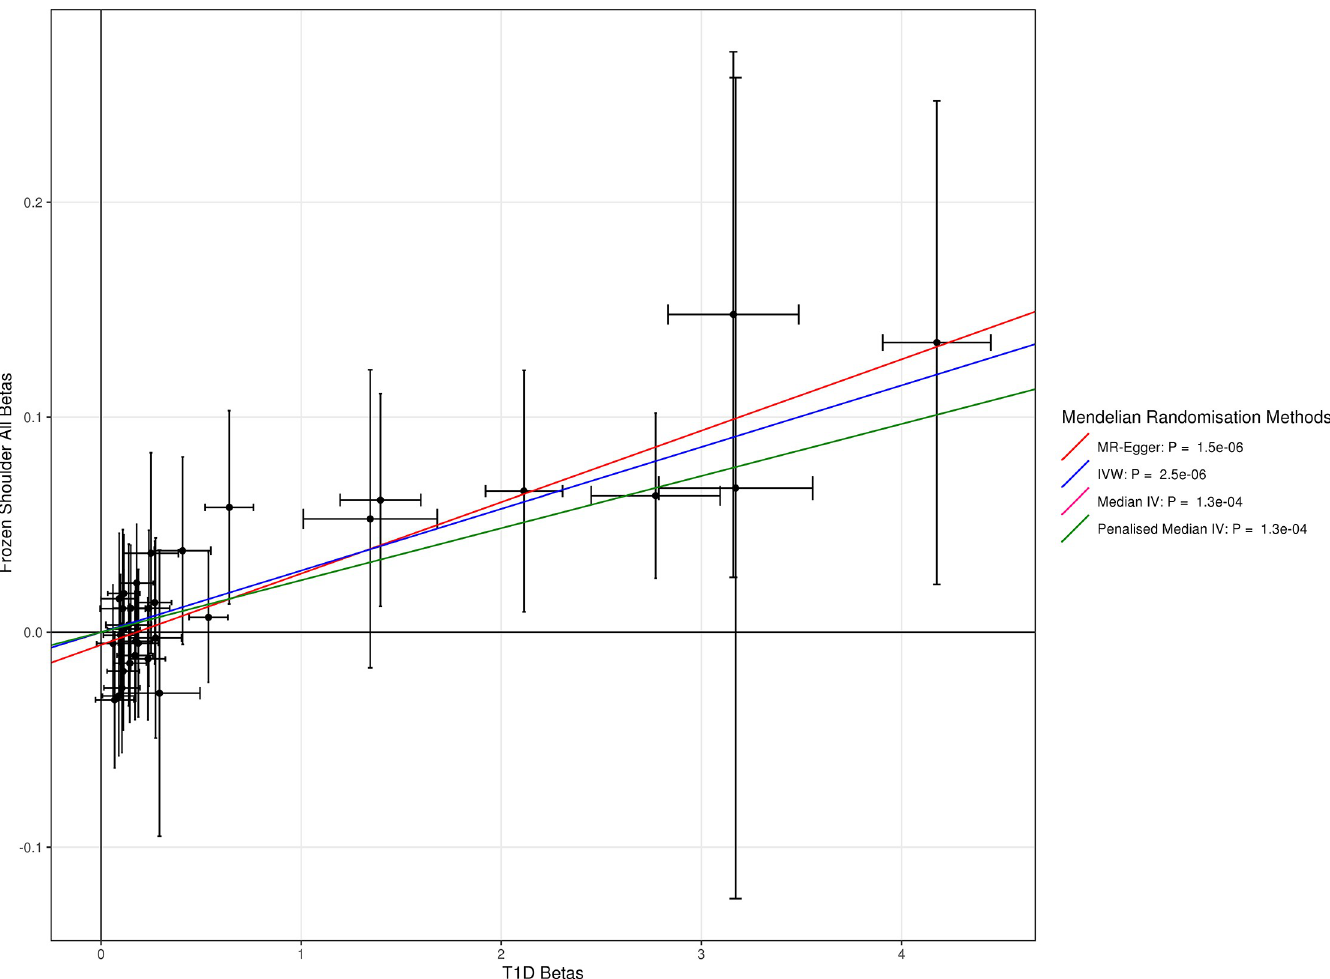
Fig 2. Two Sample Mendelian Randomization Results, showing for each SNP in the Type 1 Diabetes GRS in [20], the log-odds ratio for type 1 diabetes on the x axis and the log-odds ratio for frozen shoulder (defined by ICD-10, OPCS and GP records) on the y